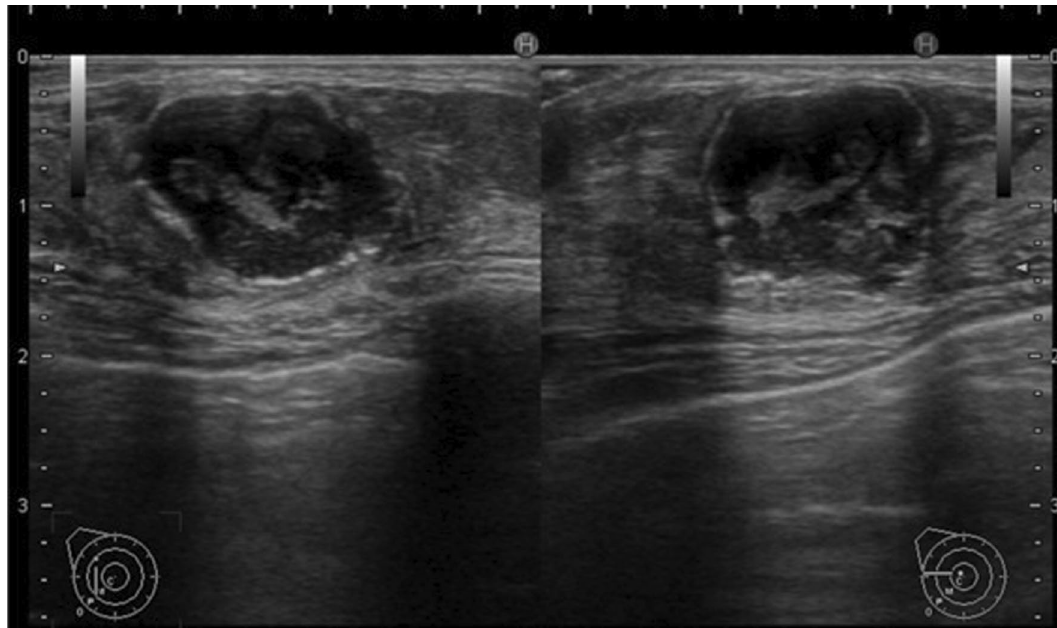
Fig. 2 Ultrasonograph showing a 1.8-cm hypoechoic irregular mass at the 9 o’clock position of the right